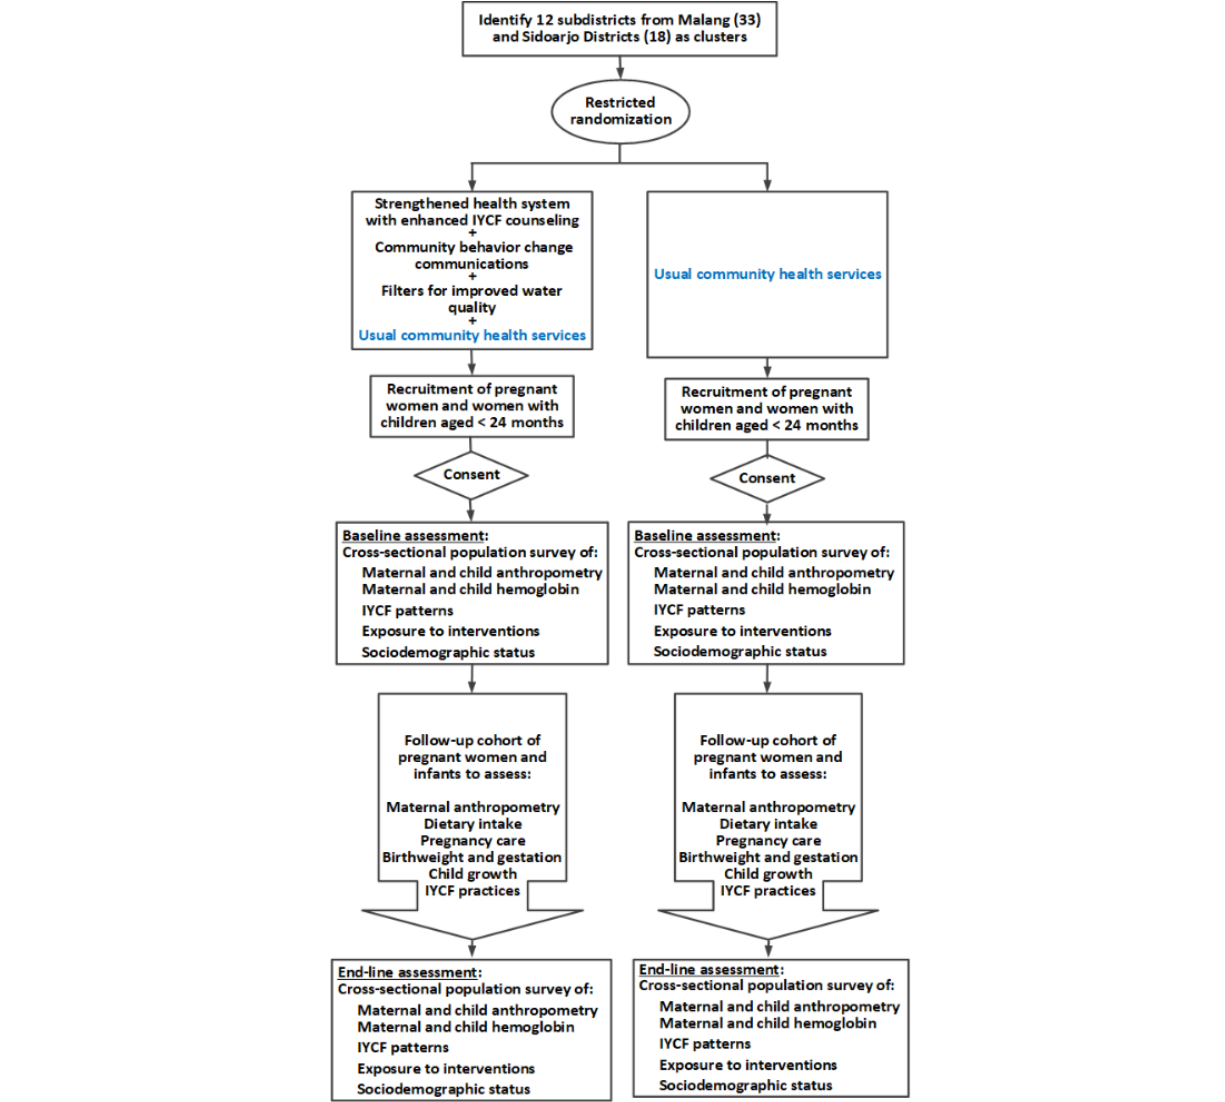
Figure 1. Diagram of the study design for the impact evaluation. IYCF: infant and young child